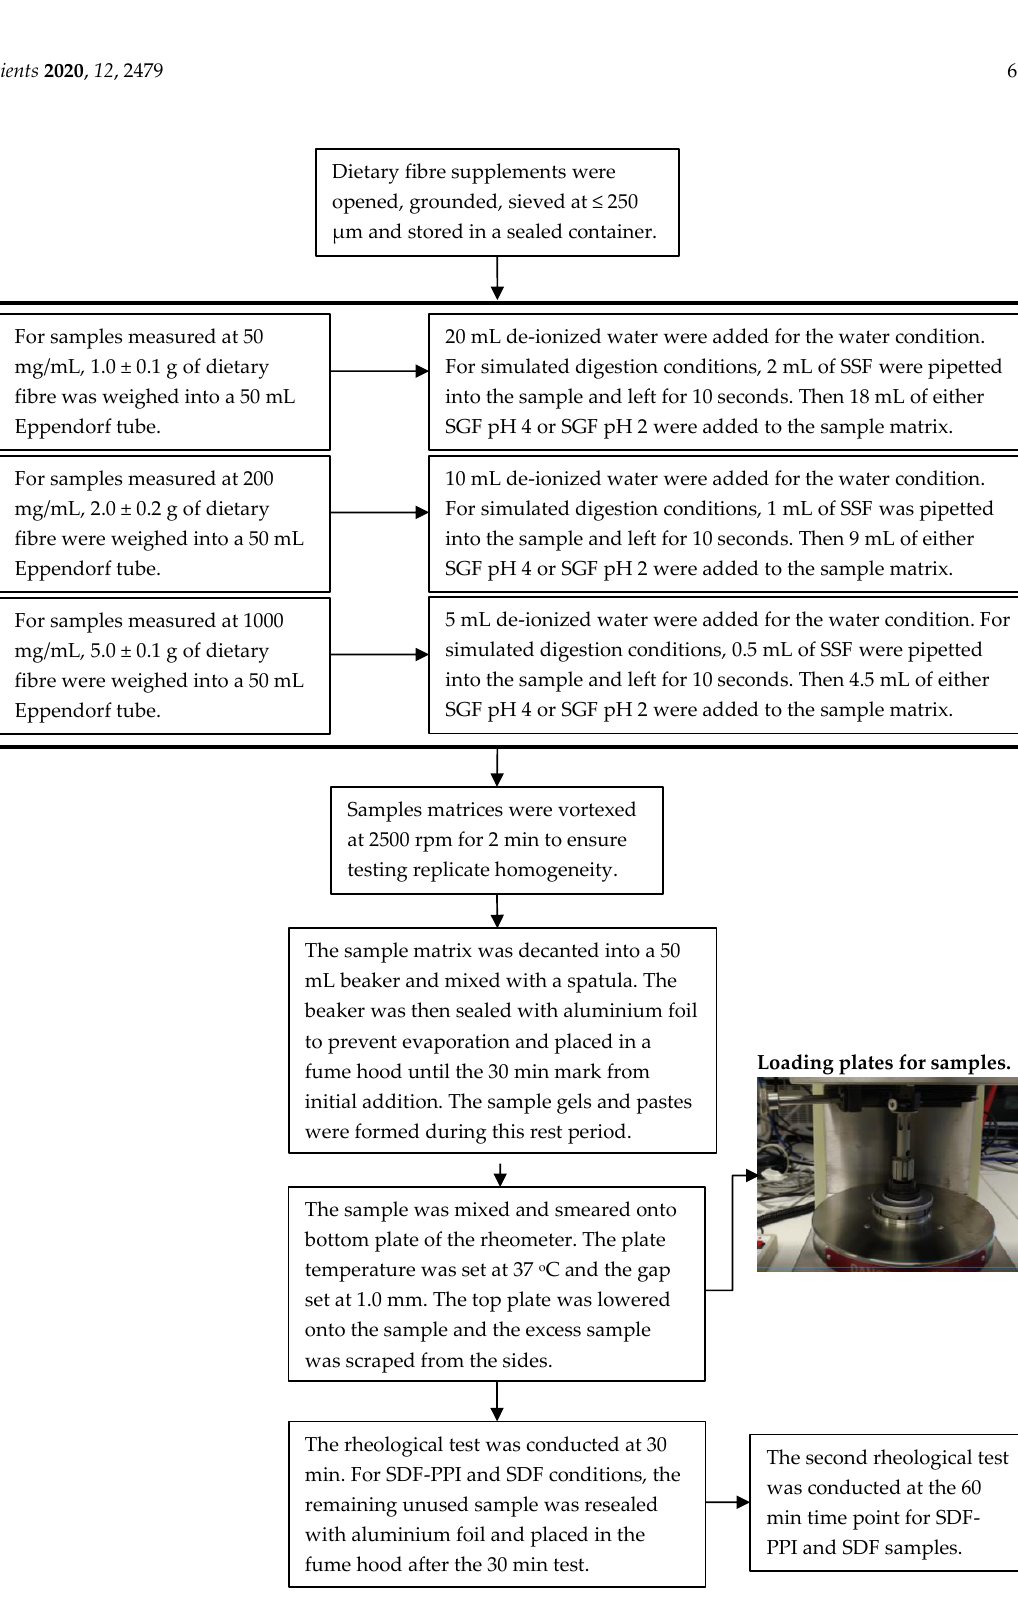
Figure 1. Procedural flowchart for sample preparation and rheological analysis. Keywords as follows: SSF (simulated salivary fluid), SGF (simulated gastric fluid), SDF-PPI (simulated digestion fluid proton pump inhibitor at pH 4), SDF (simulated digestion fluid at pH 2).